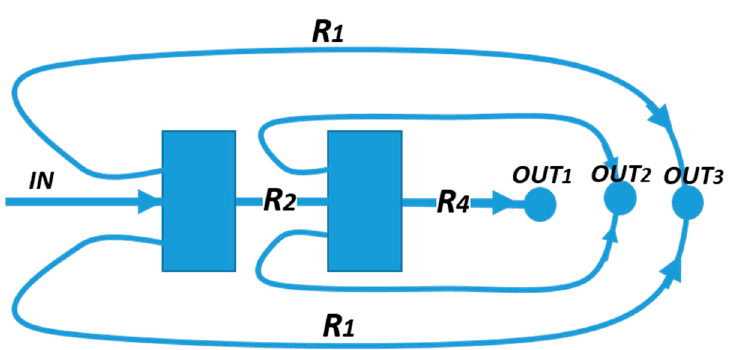
Figure 9. Inertial micro-fluidic multimodal separation designed by Wang et al. [81]. The micro-fluidic resistance network comprises two sorting chambers and three exits for particles, relying on their dimensions. Adapted from [88].